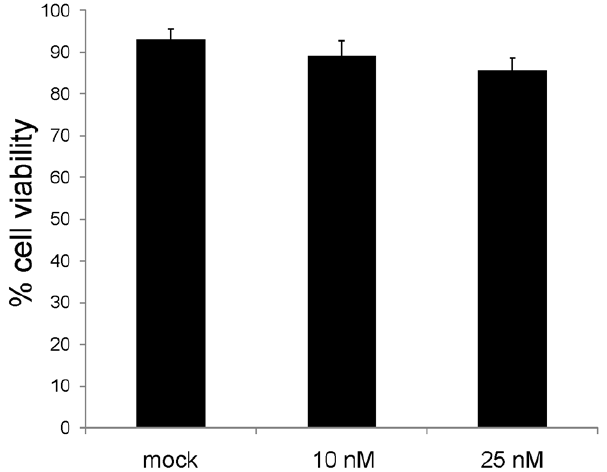
Figure 6. Cell viability measurement. HepG2 cells were transfected for 4h with water for mock or 10 and 25 nM LNA ASO using Lipofectamine 2000 and incubated for 48h. The cells were then treated with Alamar blue reagent and analyzed on an Elisa plate reader for cell viability.